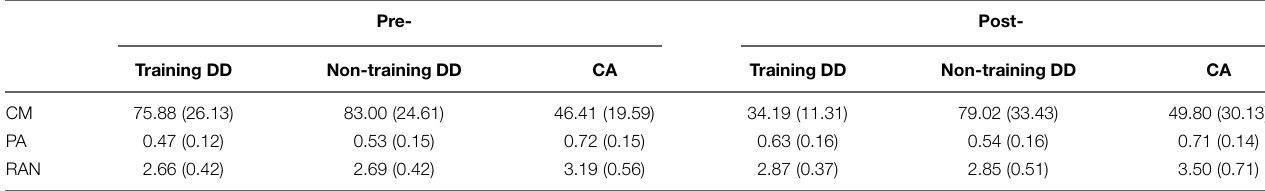
TABLE 2 | The performance of pre-test and post-test for three